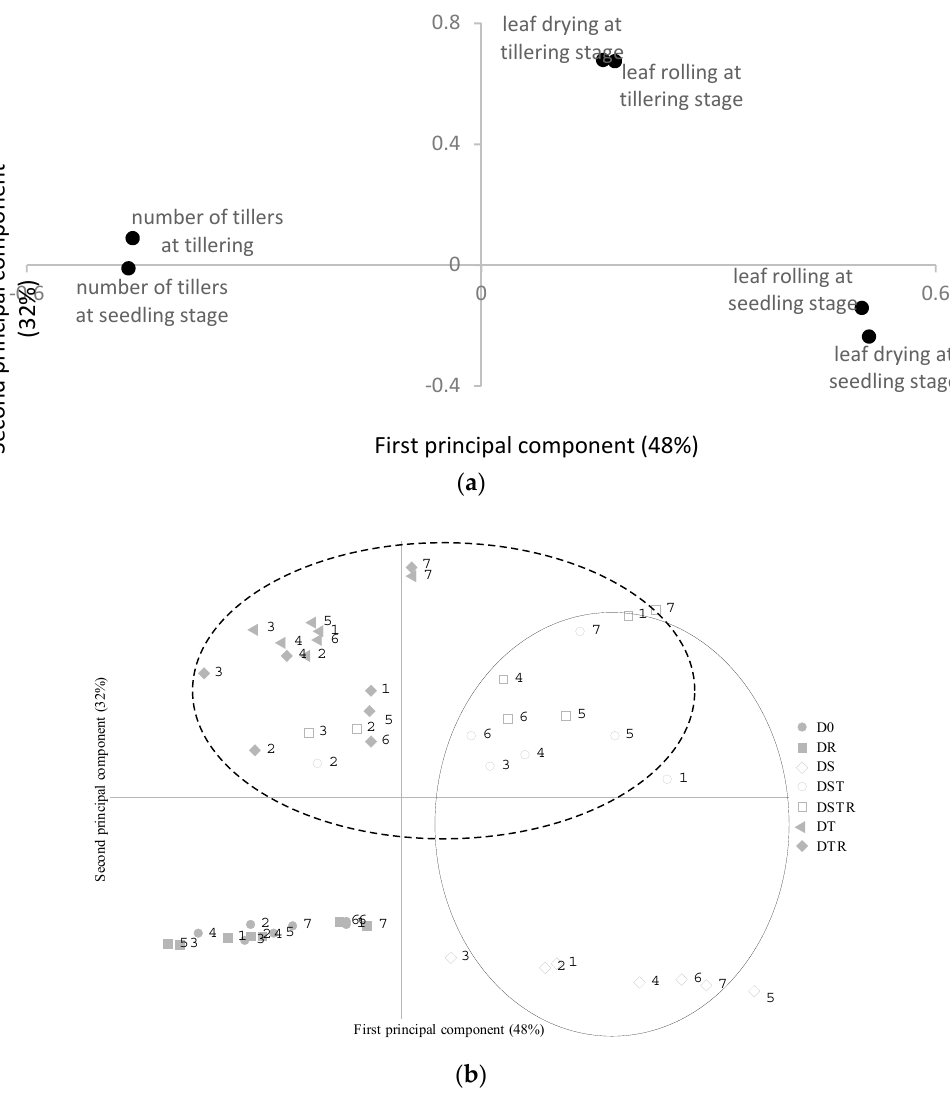
Figure 1. Loading ( a ) and score ( b ) plots from principal components analysis of leaf rolling, leaf drying, and number of tillers during drought at vegetative stages. Treatments, including drought at the seedling stage, are encircled by a full line, while treatments, including drought at tillering, are encircled by a dotted line. D0: Well-watered during the whole growing season; DS: Drought treatment at the seedling stage; DST: Drought treatment at the seedling and tillering stage; DT: